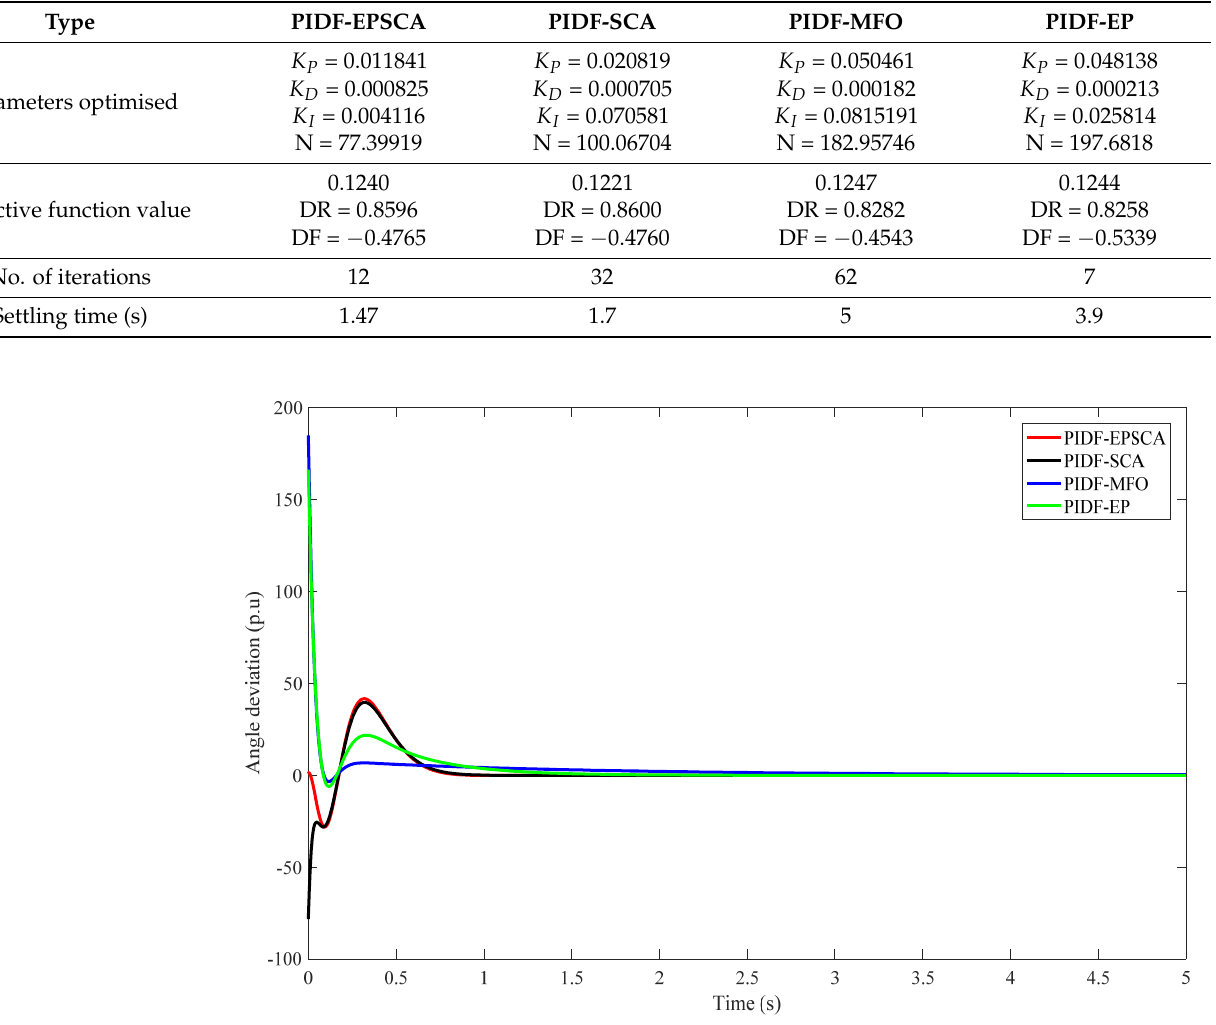
Figure 24. Angle deviation response of the TCSC-PIDF controller using PIDF-EPSCA, PIDF-SCA, PIDF-MFO, and PIDF-EP techniques for Scenario